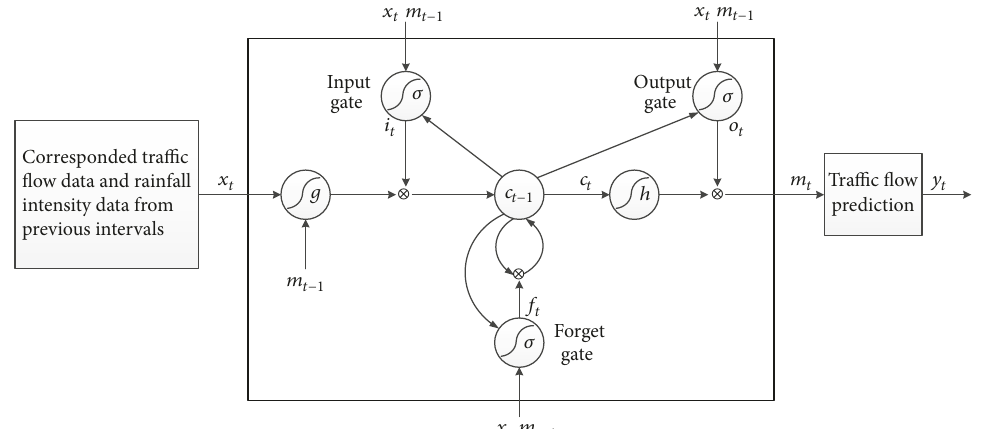
Figure 3: The structure of the R-LSTM.